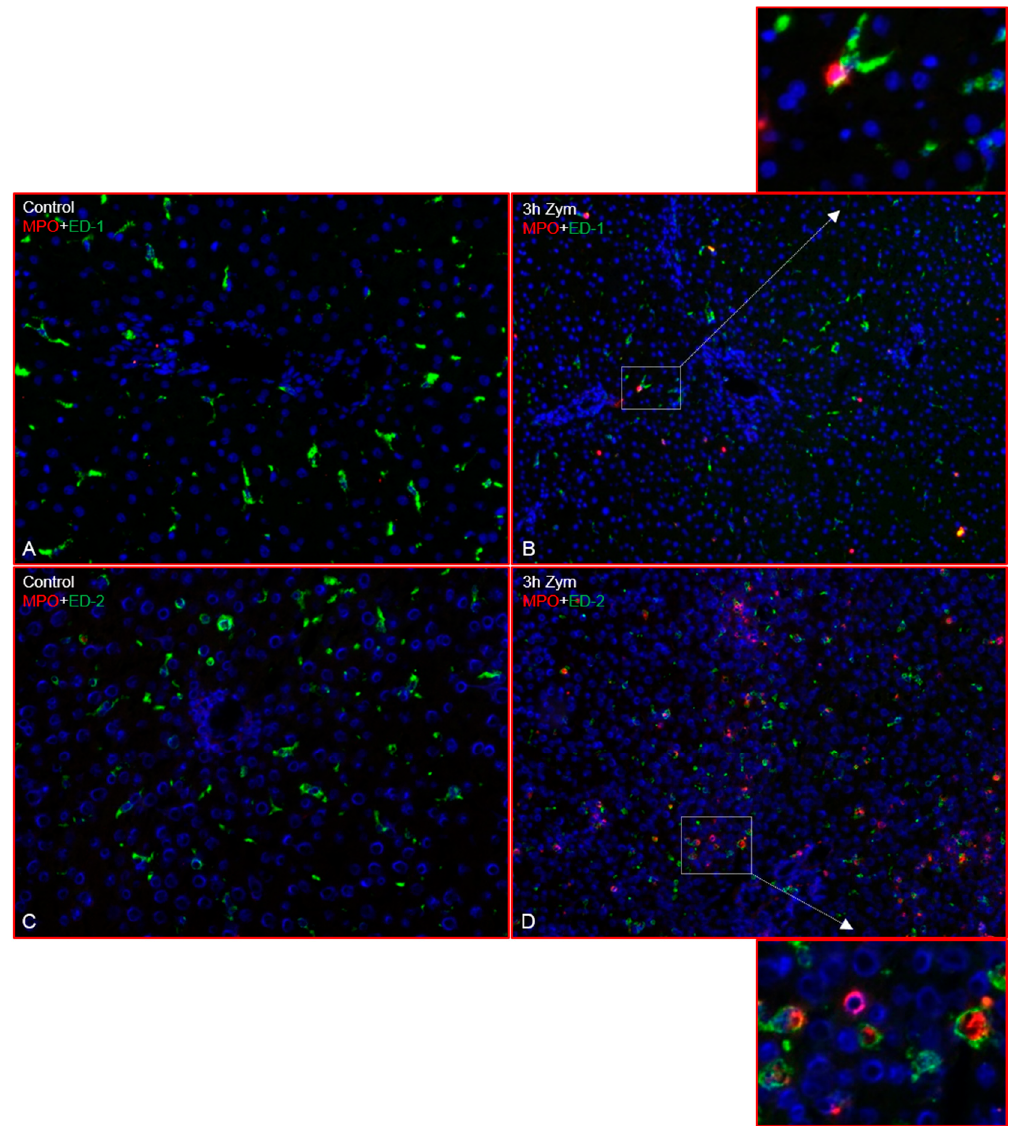
Figure 3. Double immunofluorescence staining of rat liver sections (Zymosan treatment) with antibodies directed against ED-1 and ED-2 (green) and MPO (red) followed by fluorescence immunodetection. Liver sections from different time points of study are shown: control ( A ) and 3 h ( B ) with antibodies against ED-1 and MPO; control ( C ) and 3 h ( D ) with antibodies against ED-2 and MPO. Results shown are representative pictures of six animals and six slides per time point. (Original magnification 200×).